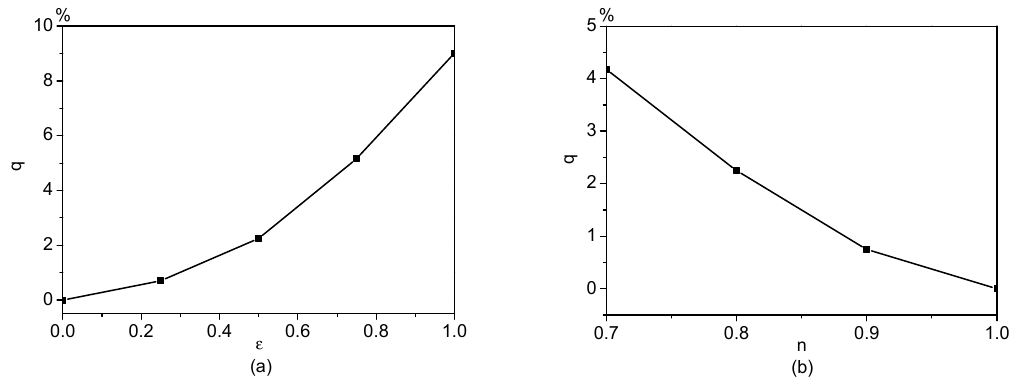
Figure 8. Flow enhancement of electroosmotic flows of power-law fluids by an AC/DC combined electric field with E 0 = 1, ω = π and ψ w = − 1. ( a ) Variation of q with ε when n = 0.8; ( b ) Variation of q with the flow behavior index n when ε = 0.5.